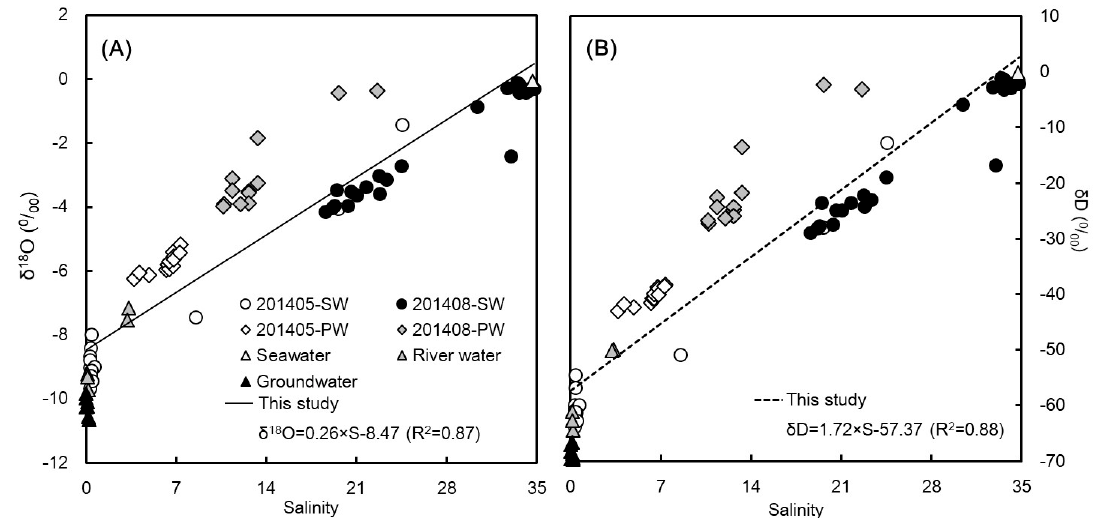
Figure 5. The diagram of ( A ) δ 18 O and ( B ) δ D vs. salinity for all water samples collected from the Gaomei Wetland, including SW (surface coastal water), PW (pore water from 35 cm below the seabed), groundwater, river water (from the outlet of the Da-Chia River and the Qingshui drainage), and offshore seawater. They showed good linear relationships with salinity: (A) δ 18 O = 0.26 × S − 8.47, R 2 = 0.87, and (B) δ D = 1.27 × S − 57.37, R 2 = 0.88.